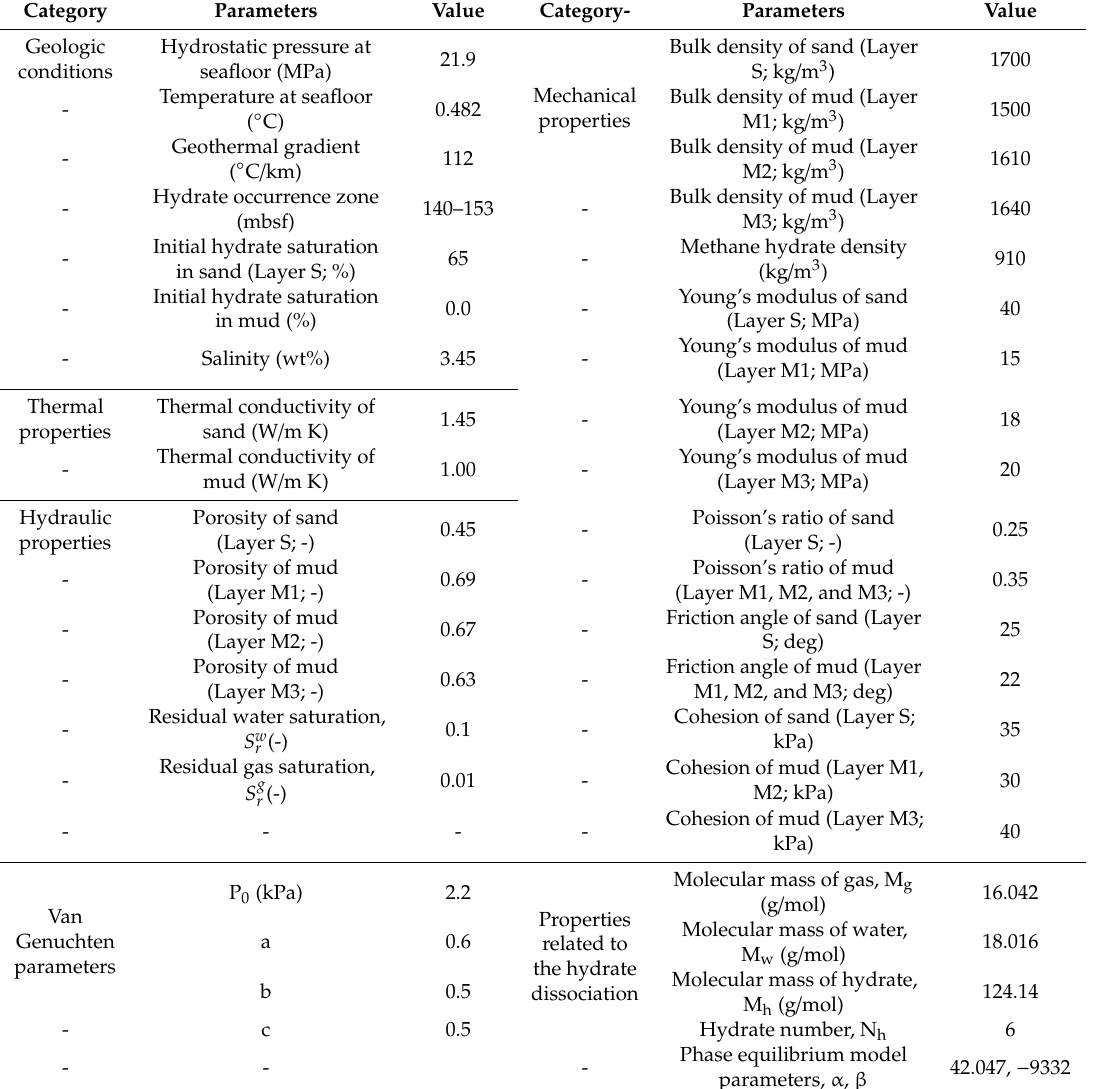
Table 2. Thermal, hydraulic, and mechanical input properties used in this study